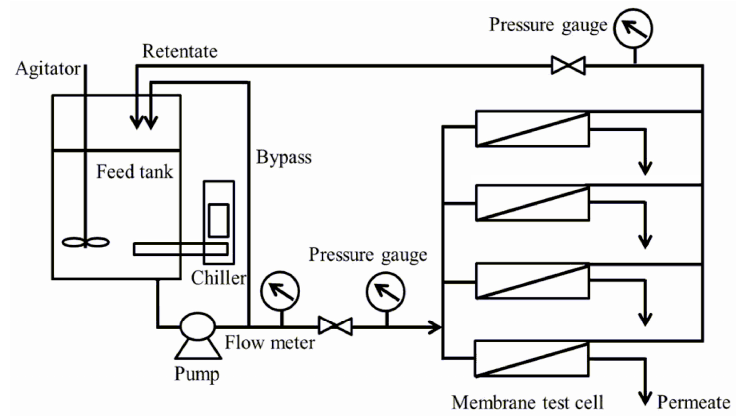
Figure 2. Schematic of flat sheet reverse osmosis crossflow filtration system.